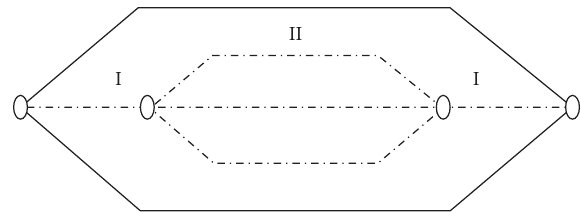
Figure 1: Schematic diagram of the planning sections of urban rail transit